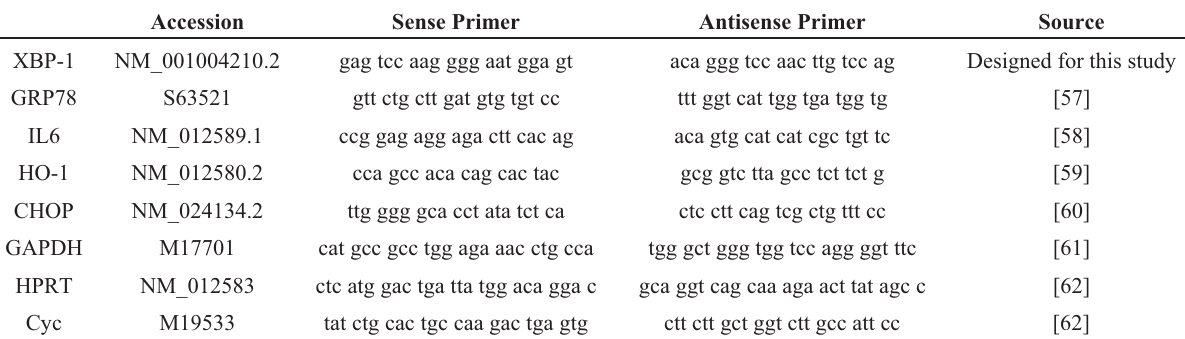
Table 1. Primers used for analysis of gene expression by real-time